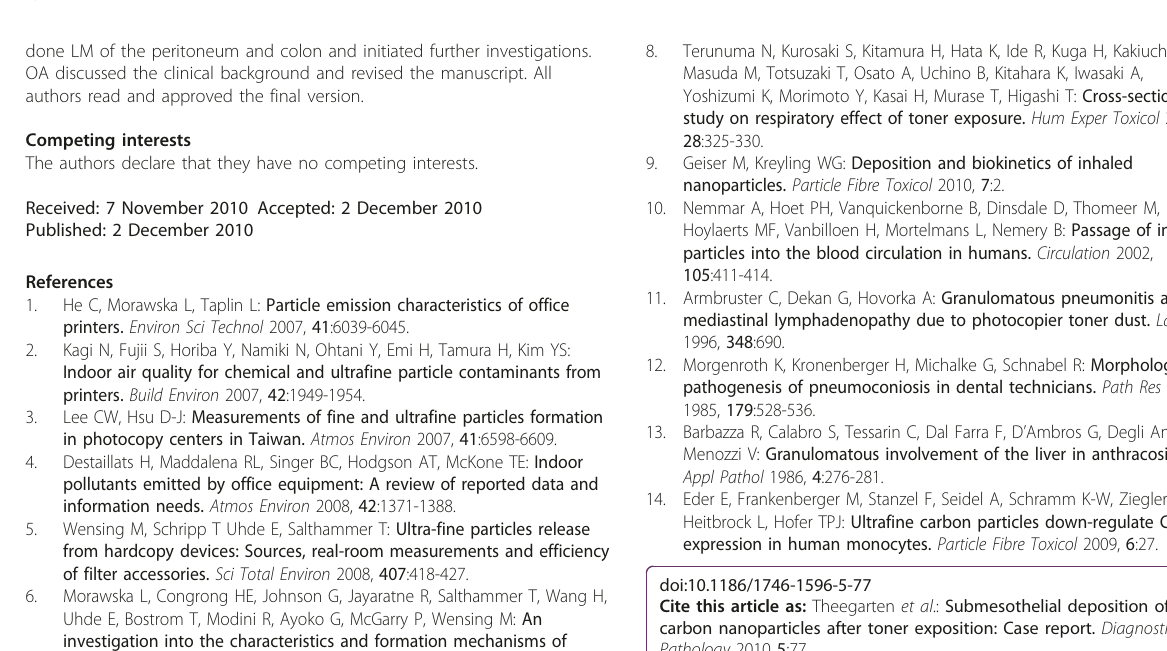
Figure 3 Transmission electron microscopy . TEM comfirms NP within phagolysosomes